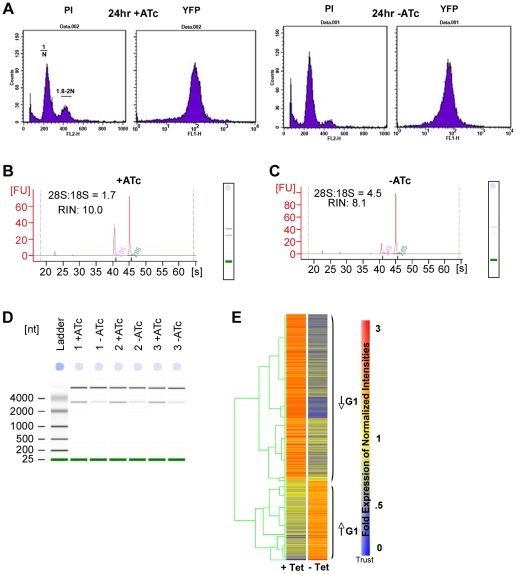
Arrest in G1 and transcriptional analysis of Δrps13 ±ATc.(A) G1 arrest shown by FACS. There is an increase of 1N and decrease of 1.8 to 2N population at 24 hours -ATc, a profile seen at the G1 phase of synchronously growing parasites. (B to D) Reduction of small subunit 18S rRNA. RNA samples used for microarray hybridizations were analyzed on a 2100 Bioanalyzer to determine RNA integrity. (B,D) +ATc samples exhibit normal rRNA ratios (1.7–2), demonstrating robust, intact RNA. (C,D) -ATc samples exhibit unusually high rRNA ratios (4.5–4.8) that were out of the normal range, suggesting abnormal rRNA integrity. The decreased area of 18S rRNA peaks in the -ATc samples suggest 18S breakdown. Panel C shows 3 replicates indicated by “1, 2, 3.” (E) Transcriptome analysis of Δrps13 ±ATc parasites. Transcriptional differences demonstrate arrest in G1 of the cell cycle for -ATc parasites. Over 60% of the genes that have diminished expression -ATc overlap with genes that are diminished at G1, and over 40% of genes with increased expression -ATc overlap with genes that are up regulated at G1. Annotated transcriptome data are included in Table S2.